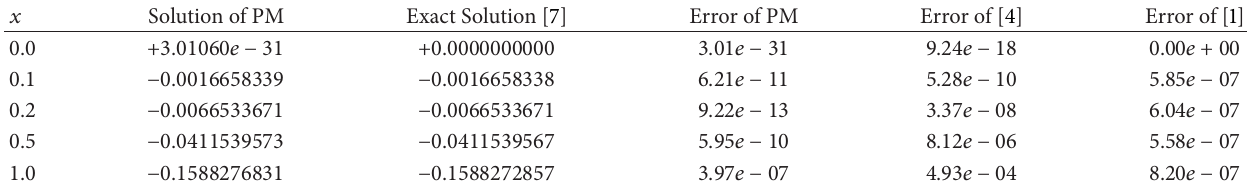
Table 1: The exact and approximated solution of Example 3 together with the error comparisons for 𝑁 = 10 .